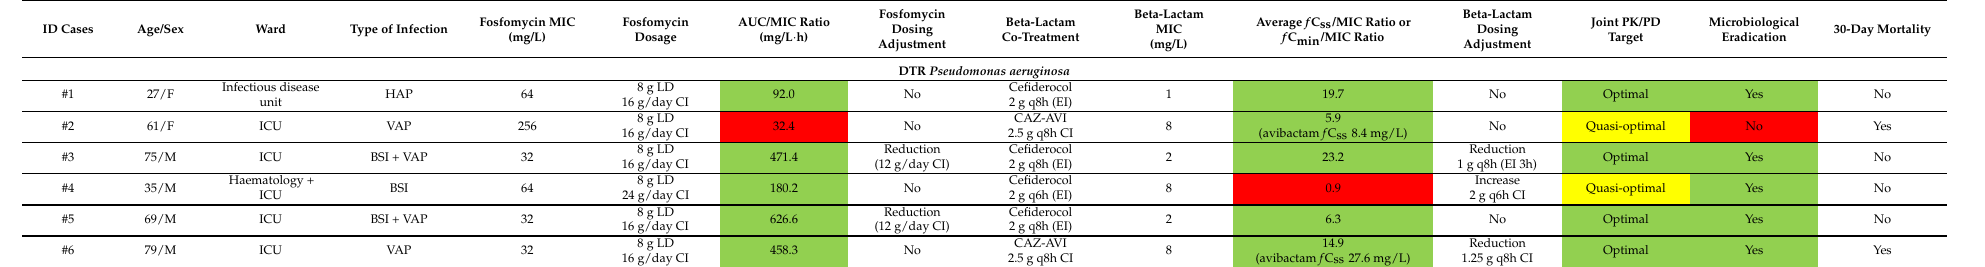
Table 1. Demographic and clinical features of patients with severe infections caused by DTR-PA treated with combination therapy including fosfomycin plus novel